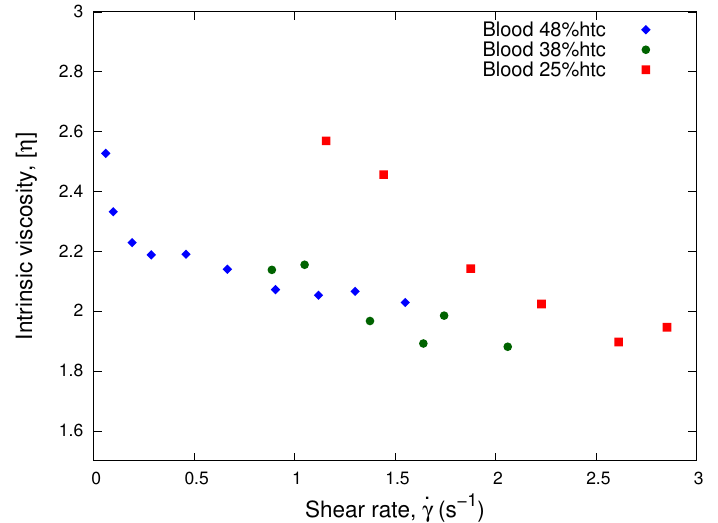
Figure 9. Intrinsic viscosity vs. shear rate. The plot shows the intrinsic viscosity obtained from the Quemada model, as shown in Equation (20). We observe how the value of the intrinsic viscosity approaches 2 at high shear rates corresponding to the maximum packing fraction when blood viscosity is close to